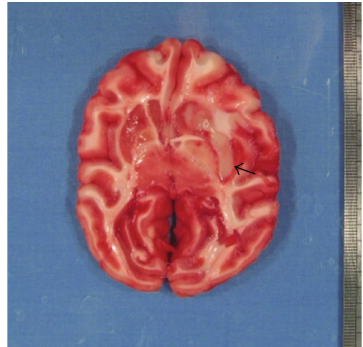
Figure 8: Same animal with Figures 5, 6, and 7, TTC staining shows infarction in basal ganglion (black arrow), temporal lobe did not develop to infarction. The recovered high signal on DWI is